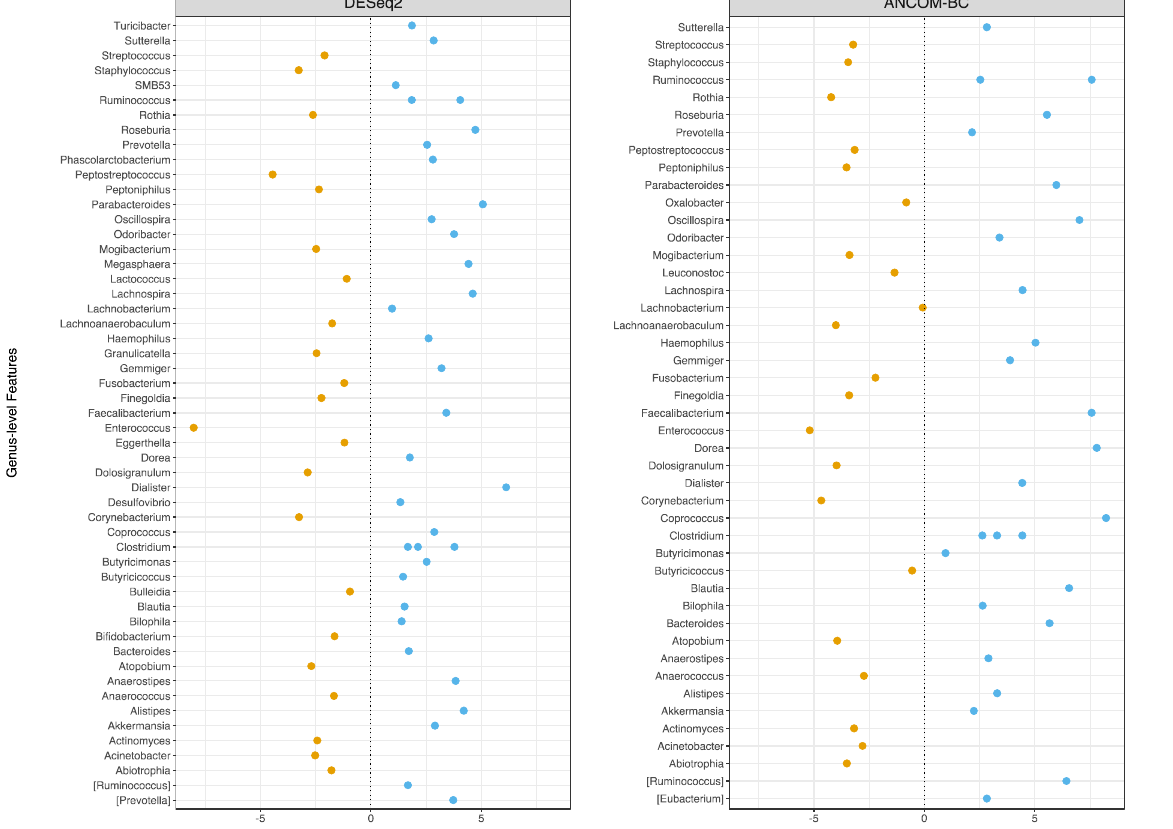
Figure 4. Differential abundance testing identifies genera with high abundance between AGE cases and healthy controls. DESeq2 (left) and ANCOM-BC (right) were used for differential abundance testing. Genera that passed multiple test correction (Benjamini and Hochberg’s FDR < 0.05) are shown. Dots represent the estimated effect size distribution as log2 (fold-change) and W for DESeq2 and ANCOM-BC, respectively. Negative values represent genera enriched in AGE cases and positive values represent genera enriched in healthy controls.